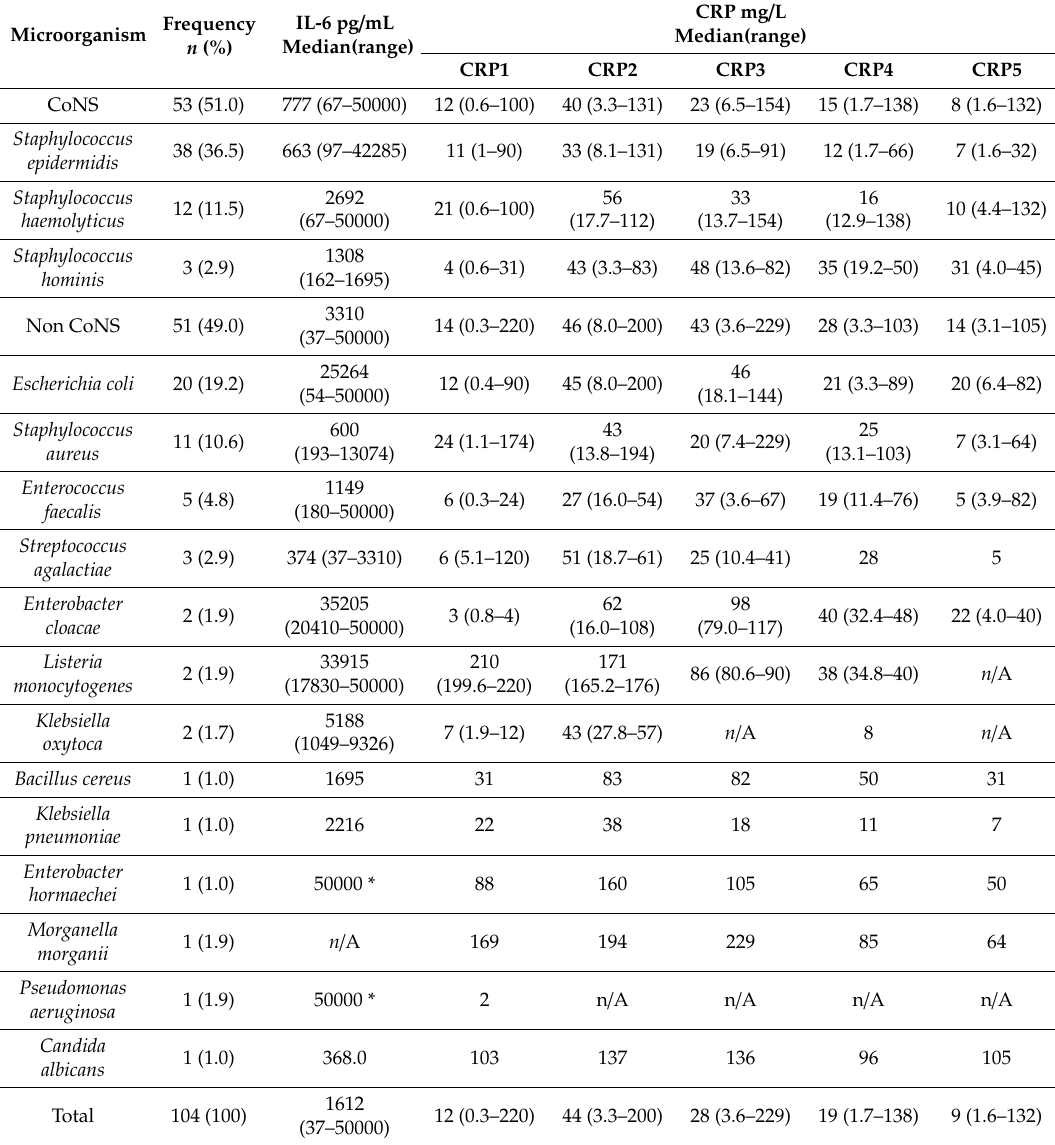
Table 2. Frequency of microorganisms isolated from blood culture positive neonates, and the median and range of IL-6 and CRP